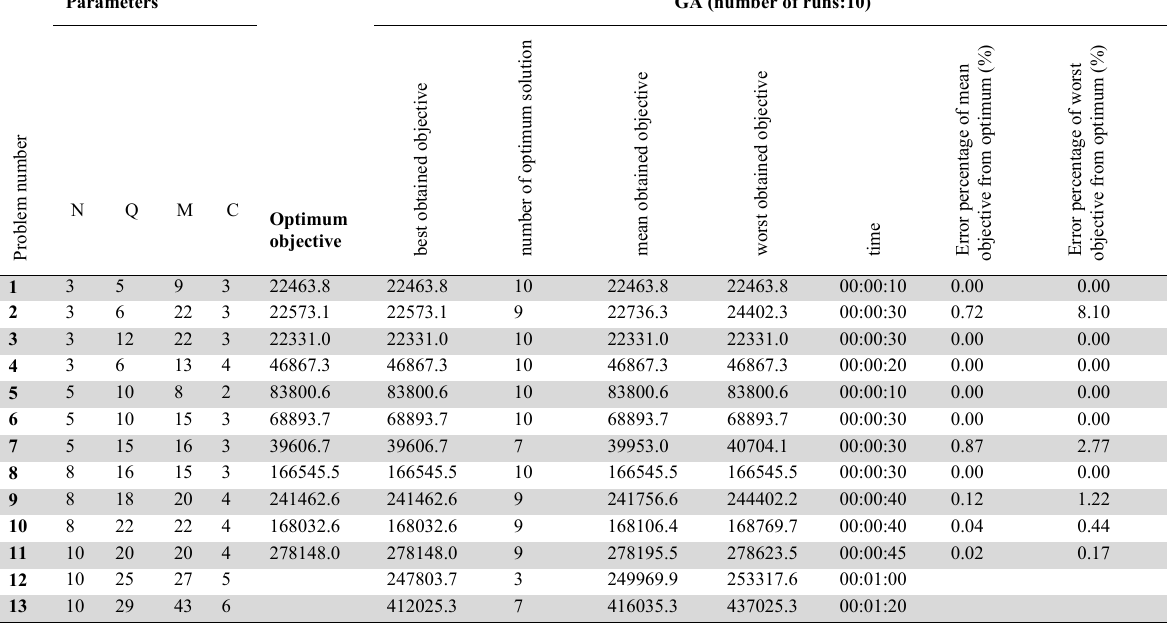
Solution of numerical examples with the suggested genetic algorithm